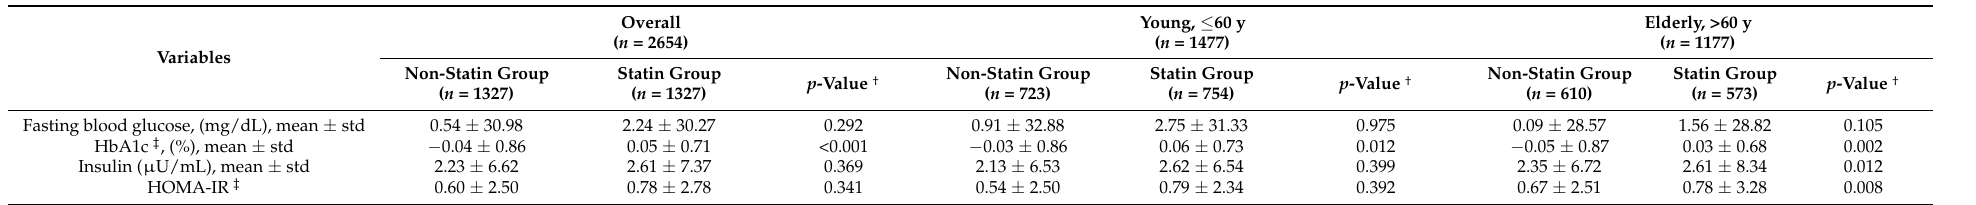
Table 4. Changes in serum levels of fasting blood glucose, HbA1c, insulin and HOMA-IR index among non-statin and statin users after propensity score matching, overall and in young and elderly